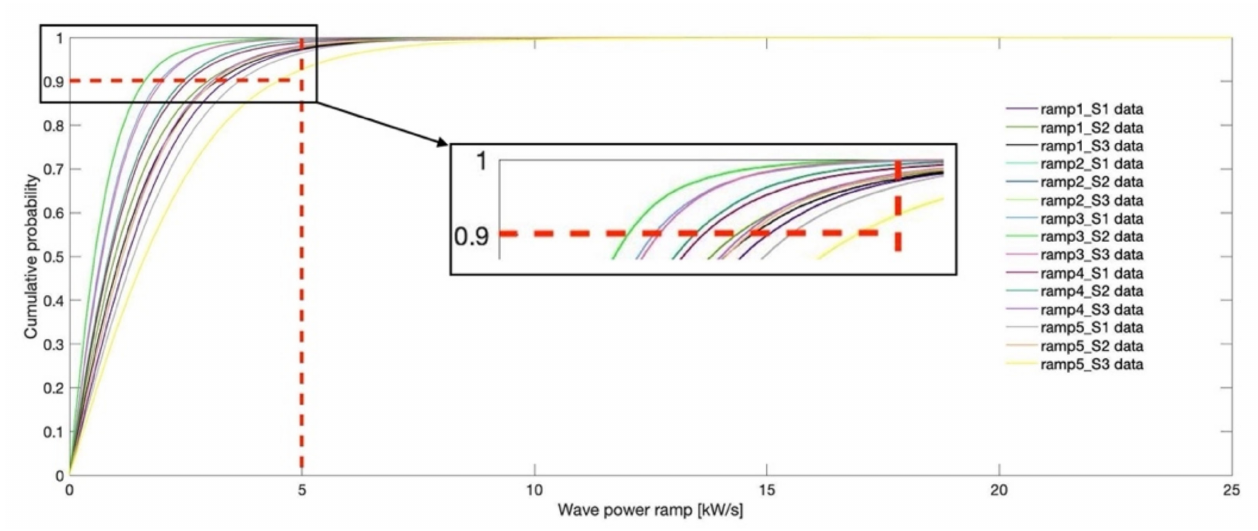
Figure 6. Cumulative density function of the wave power ramp.